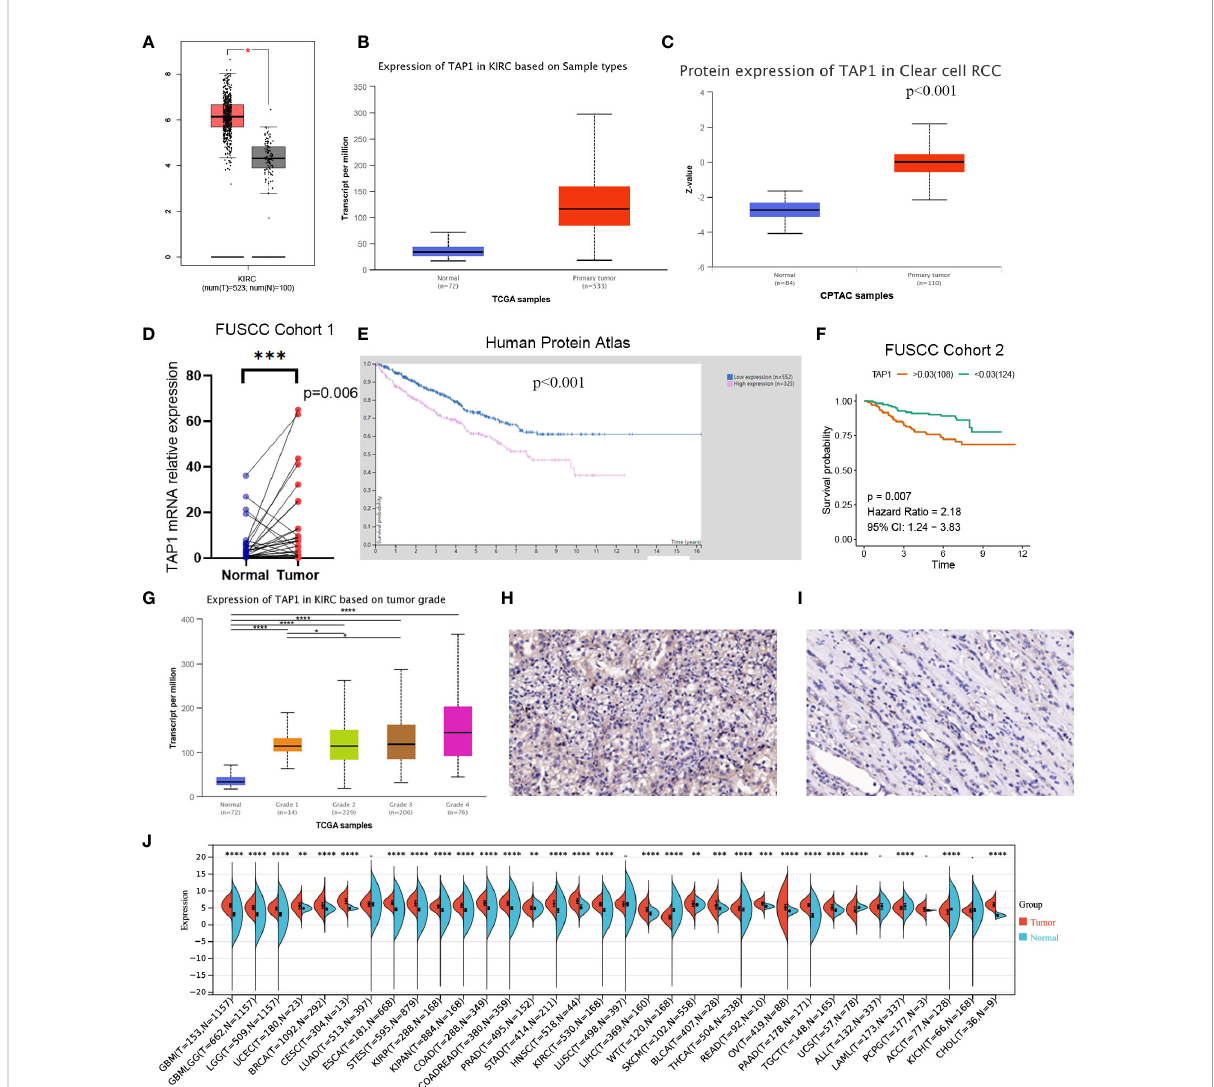
FIGURE 1 Transporter associated with antigen processing 1(TAP1) expression pro fi les in human normal and clear cell renal cell carcinoma (ccRCC) tissues. (A, B) TAP1 has a higher mRNA expression level in cancer than para-cancer tissues based on the Cancer Genome Atlas (TCGA) database. (C) TAP1 has a higher protein expression level in cancer than para-cancer tissues based on Clinical Proteomic Tumor Analysis Consortium (CPTAC) database. (D) TAP1 has a higher mRNA expression level in cancer than para-cancer tissues based on Fudan University Shanghai Cancer Center (FUSCC) cohort 1. (E, F) Survival curves in Human Protein Atlas (n=877, p<0.001) and FUSCC proteomic cohort (n=232, p<0.01) with signi fi cance. (G) TAP1 expression is positively correlated with advanced cancer (*, P < 0.05; **, P < 0.01; ***, P < 0.001; ****, P < 0.0001). (H, I) Immunohistochemical analysis showed a higher TAP1 expression level in ccRCC samples. (J) TAP1 expression levels in para-cancer tissues from the TCGA